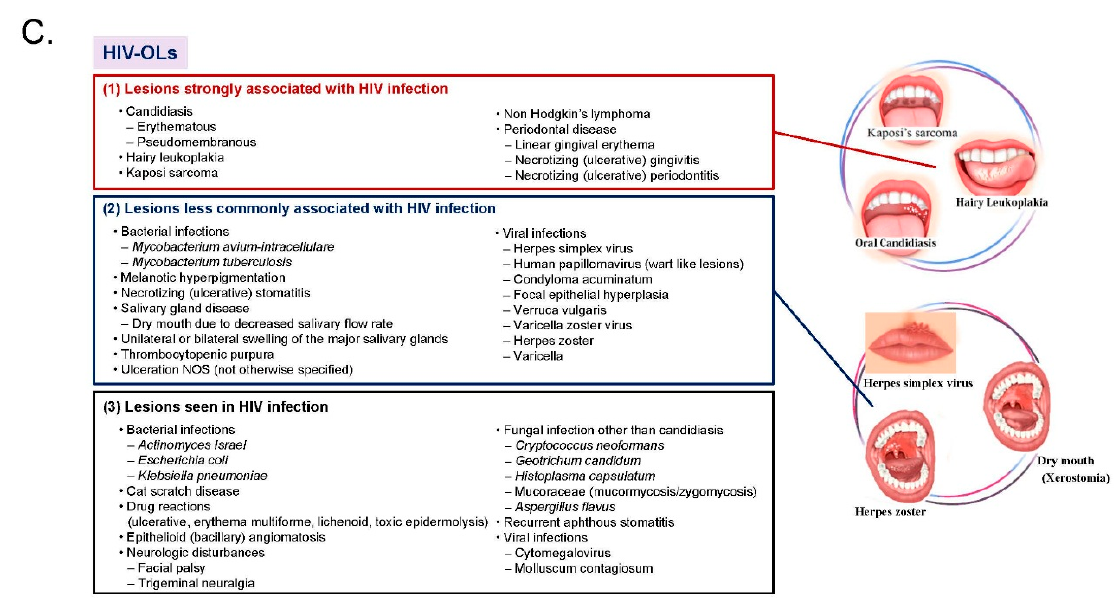
Figure 1. Life cycle and effects of human immunodeficiency virus (HIV). ( A ) The HIV infection of cells begins when the envelope glycoprotein of a viral particle binds to both cluster of differentiation 4 (CD4) and a co-receptor that is a member of the chemokine receptor family. Once inside the cells, the viral genome is reverse-transcribed into DNA and incorporated into the cellular genome. Viral gene transcription and viral reproduction are stimulated by signals that normally activate the host cell. Production of the virus is accompanied by cell death. ( B ) Infection with HIV induces immunosuppression, which in turn enables many kinds of bacteria, fungi, and viruses to grow in the oral cavity. HIV-infected individuals usually exhibit immune dysfunction prior to depletion of their CD4-positive T-helper cells. The progressive immune deficiency is accompanied by a wide range of opportunistic infections and neoplasms, such as candidiasis, Kaposi sarcoma, and hairy leukoplakia, in the oral cavity. ( C ) The 1993 EC-Clearinghouse classification for oral lesions associated with HIV (HIV-OLs) is still globally used, despite some controversy as to its current relevance to periodontal diseases.